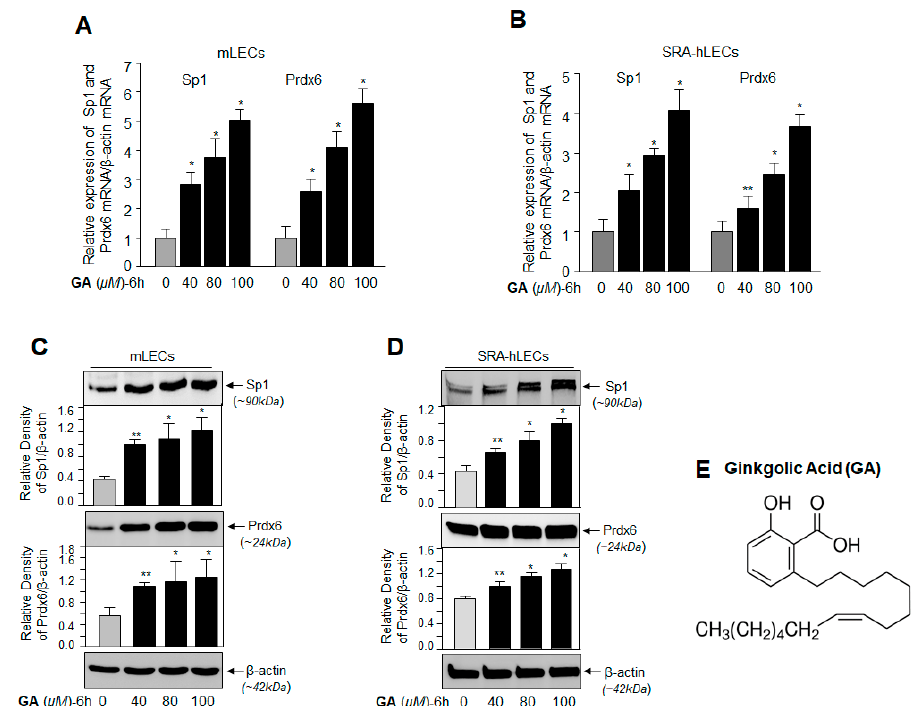
Figure 1. Ginkgolic acid (GA), a Sumoylation inhibitor, enhanced the expression of specificity protein1 (Sp1) and its target gene, Peroxiredoxin 6 (Prdx6), in a dose-dependent manner. ( A , B ) Total RNA was extracted from mLECs ( A ) and SRA-hLECs ( B ) treated with different concentrations of GA for 6 hours (h). Equal amounts of RNA were used for cDNA synthesis, and then, quantitative polymerase chain reaction (qPCR) analysis was conducted to measure the levels of Sp1 and Prdx6 using their specific probes. The data represent the mean ± SD from three independent experiments. ** p < 0.05; * p < 0.001. ( C , D ) mLECs ( C ) and SRA-hLECs ( D ) were treated with different doses of GA. Total cell lysate was prepared and immunoblotted 6 h later with Sp1 and Prdx6 antibodies, respectively. β -actin was used as loading control. ( E ) Represents GA’s chemical